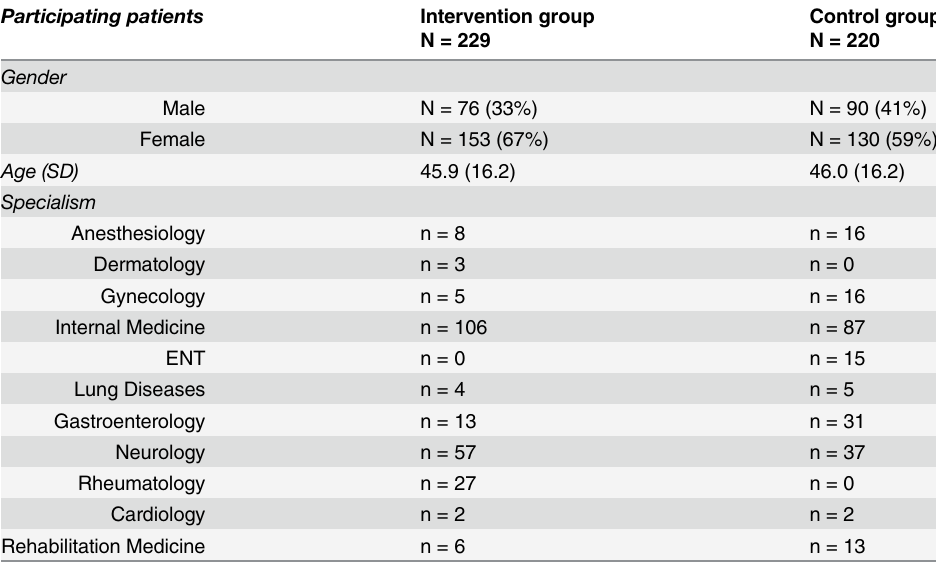
Table 3. Patient characteristics of assessed videotaped consultations. Participating